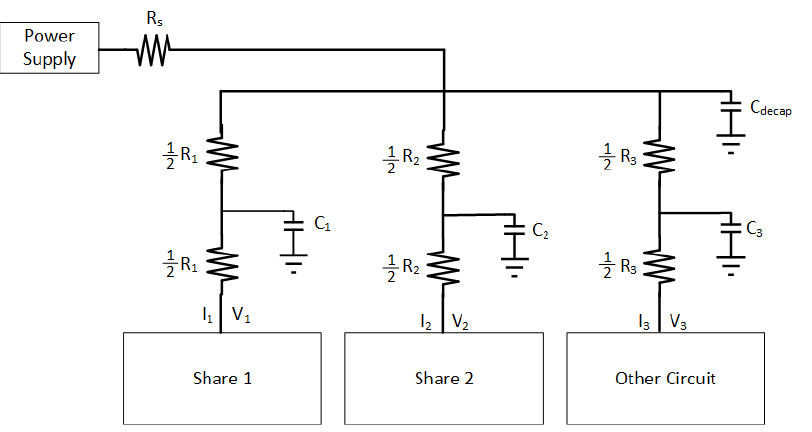
Figure 4. PDN model with masking shares and other circuitry which is modeled with a linear feedback shift register